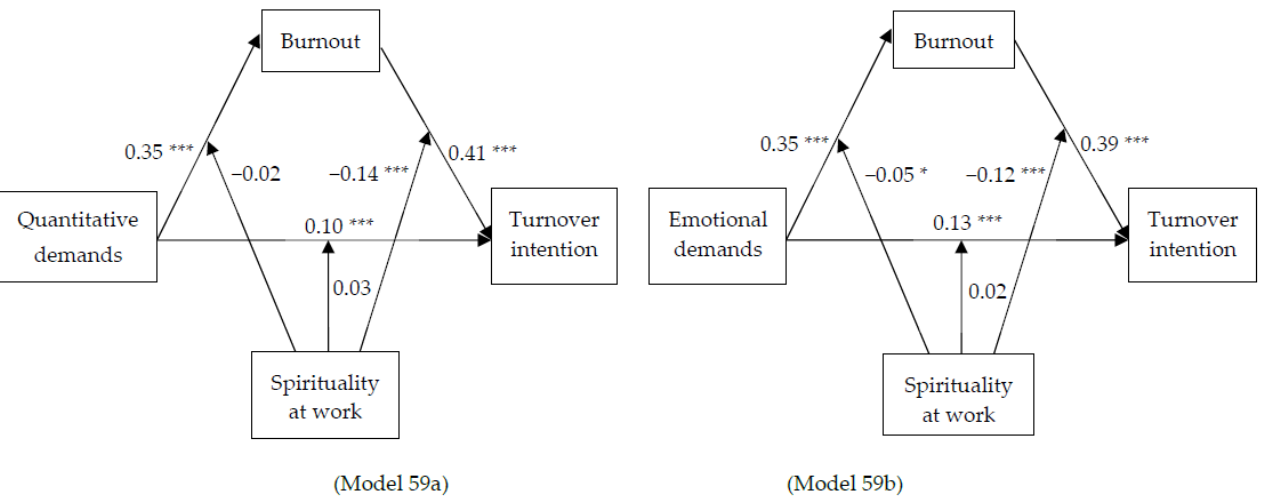
Figure 2. Standardized parameter estimates for the moderated mediation models, controlled for gender and job seniority. Model 59a: Spirituality at work as a moderator of the mediated relationship between quantitative demands and turnover intention. Model 59b: Spirituality at work as a moderator of the mediated relationship between emotional demands and turnover intention. * p < 0.05, *** p < 0.001.